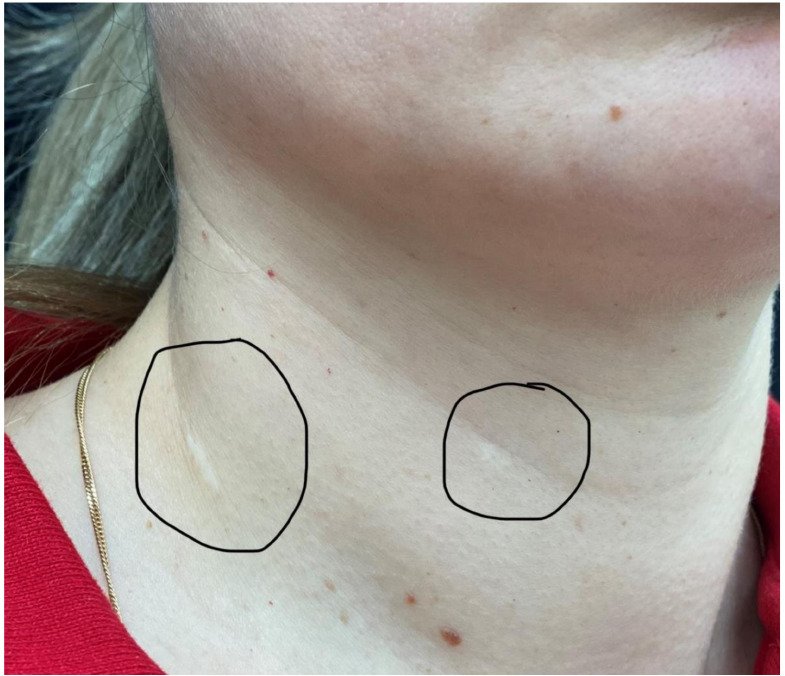
Figure 6. The scar after removal of a neoplasm on the skin of the neck after 12 years (at the lateral side) and the scar after removal of a neoplasm on the skin of the neck after five years (at the central